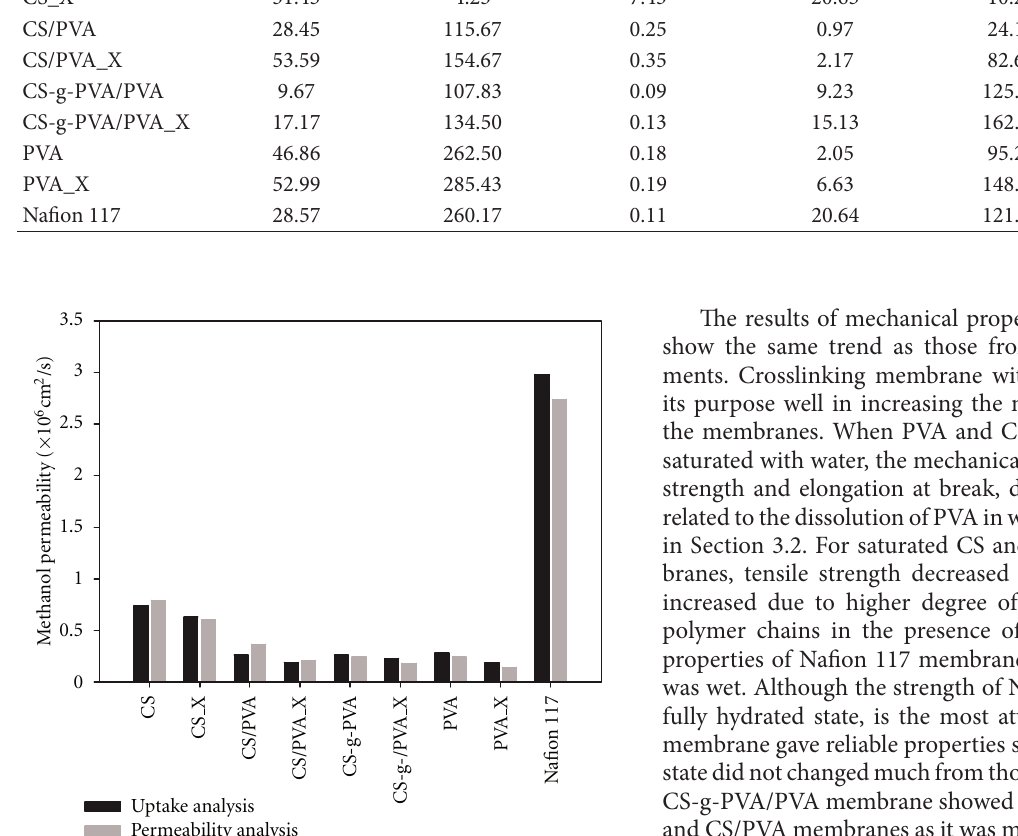
Uptake analysis Permeability analysis F 3: e comparison of the methanol permeation coefficient obtained from the methanol uptake analysis and the methanol